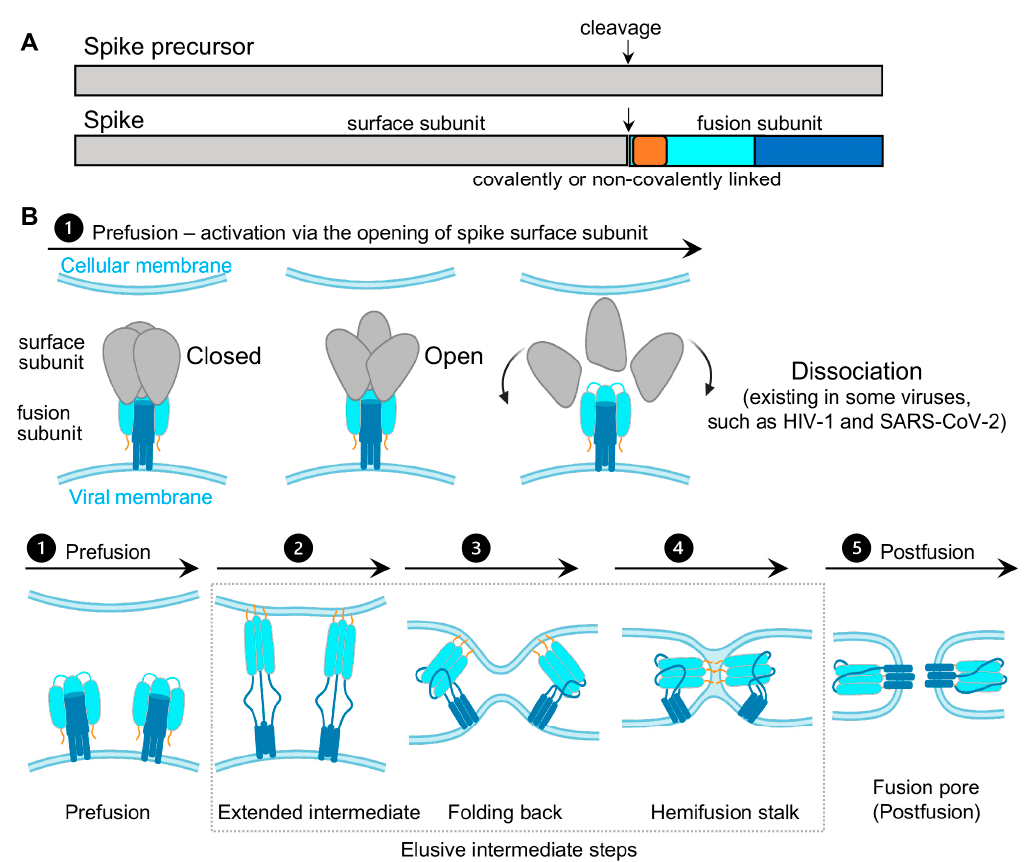
Figure 1. Class I viral fusion proteins and proposed model of viral membrane fusion. ( A ) Schematic drawing of spike precursor and cleaved spike. The spike protein is initially synthesized as a single-chain polypeptide (spike precursor) and later cleaved into a trimer of covalently or non-covalently linked heterodimer. The heterodimer consists of the surface receptor-binding subunit (gray) and the fusion subunit (fusion peptide or fusion loop (FP/FL), dark yellow; N-terminal domain, cyan; C-terminal domain, dark blue). ( B ) Proposed conformational events of virus spikes during viral membrane fusion. These events are as follows, involving conformational changes in the surface subunit (top row) and changes in the fusion subunit (low row, simplified by only showing the fusion subunit [1]). ( 1 ) Prefusion—conformations of the spike in “closed” and open forms. Spike activation proceeds through an opening of the trimer, usually in response to binding to receptor or due to a cellular cue such as low pH. For non-covalently linked spikes, dissociating/decoupling between the surface/exterior subunit with the fusion subunit has been observed/suggested after the spike opens, such as HIV-1 and SARS-CoV-2 spikes. FP/FL remains sequestered in this process. ( 2 ) Exposing, extending, and inserting the FP/FL into the cellular membrane leads to the formation of an extended prehairpin intermediate. ( 3 ) Folding back the C-terminal segment of the fusion subunit back on the N-terminal segment core brings viral and cellular membranes into proximity. ( 4 ) Further folding and dragging two membranes into contact promotes two membranes’ merging to form a hemifusion stalk. ( 5 ) The fusion subunit folds into a stable post-fusion conformation, allowing a fusion pore to form. The intermediate steps from ( 2 ) to ( 4 ) remain elusive. This proposed model does not specify or speculate the number of spikes required for fusion pore formation.